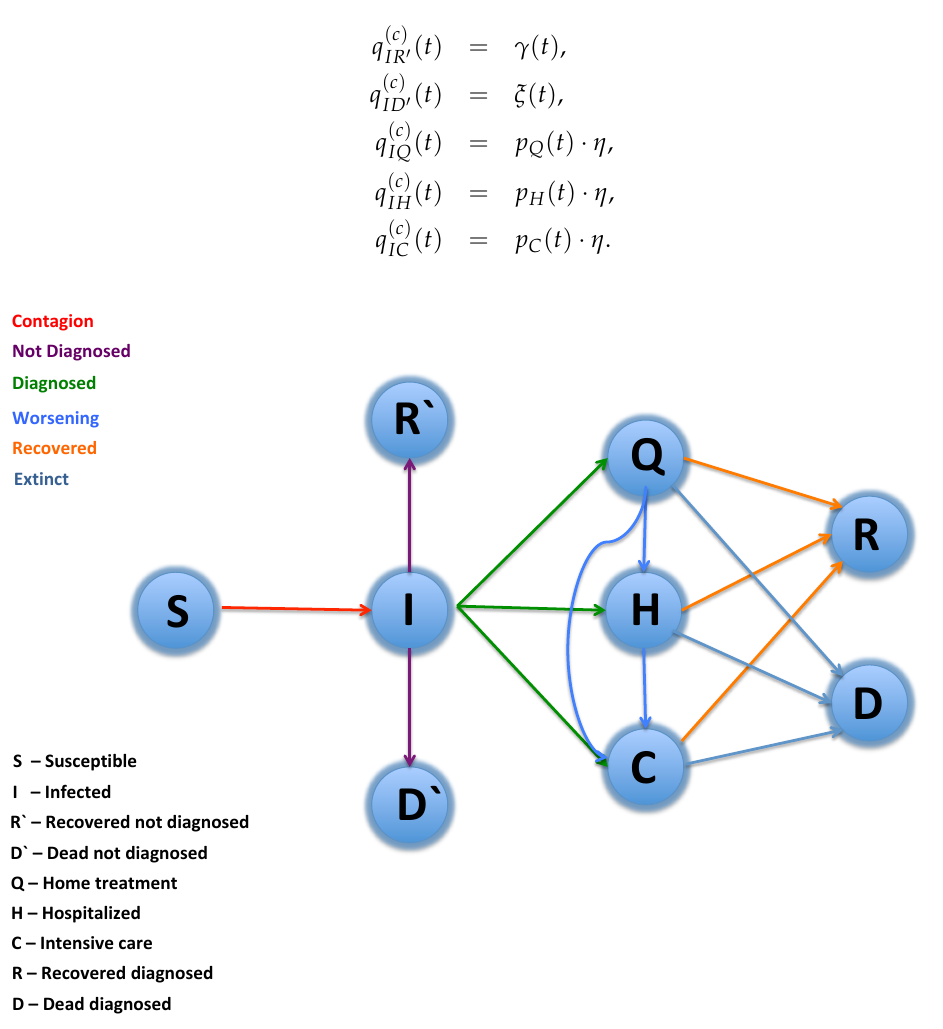
Worsening of the disease is modeled with time dependent parameters τ H ( t ) and τ C ( t ) , by defining jump rates from state Q (home treatment) to either H or C (hospitalized or intensive care), and from H to C , as